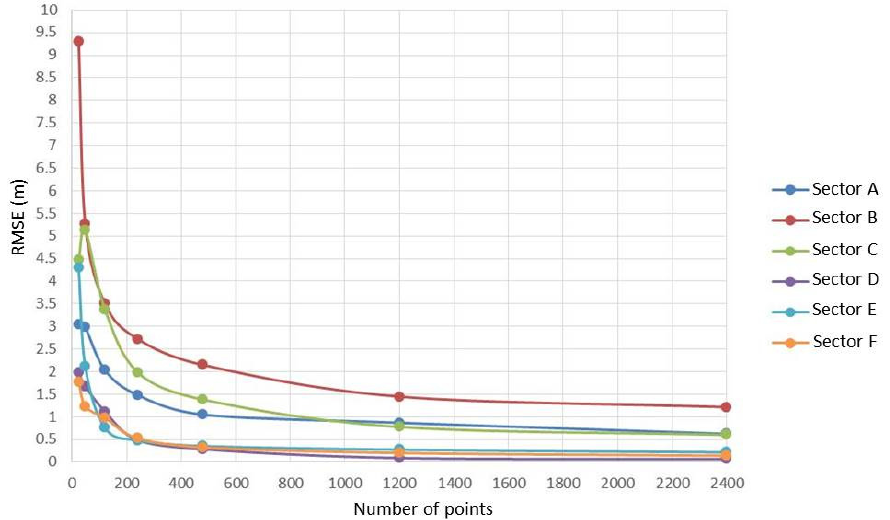
Figure 7. Direct comparison of Universal Kriging models with MBD: the variation of RMSE related to the number of points analyzed in each sector. Table 5. Statistical terms of the residuals between the Ordinary Kriging model with 2400 total points and initial dataset values for B and D sectors.